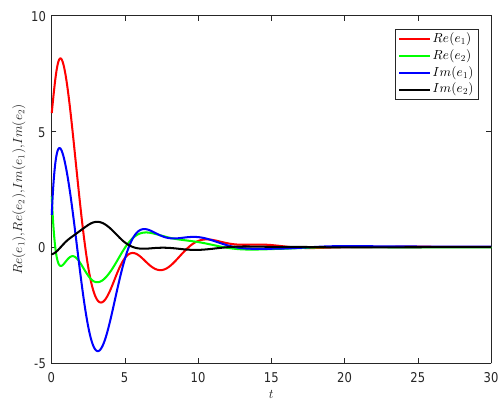
Figure 5. The curves dynamics of error system e ( t ) in Example